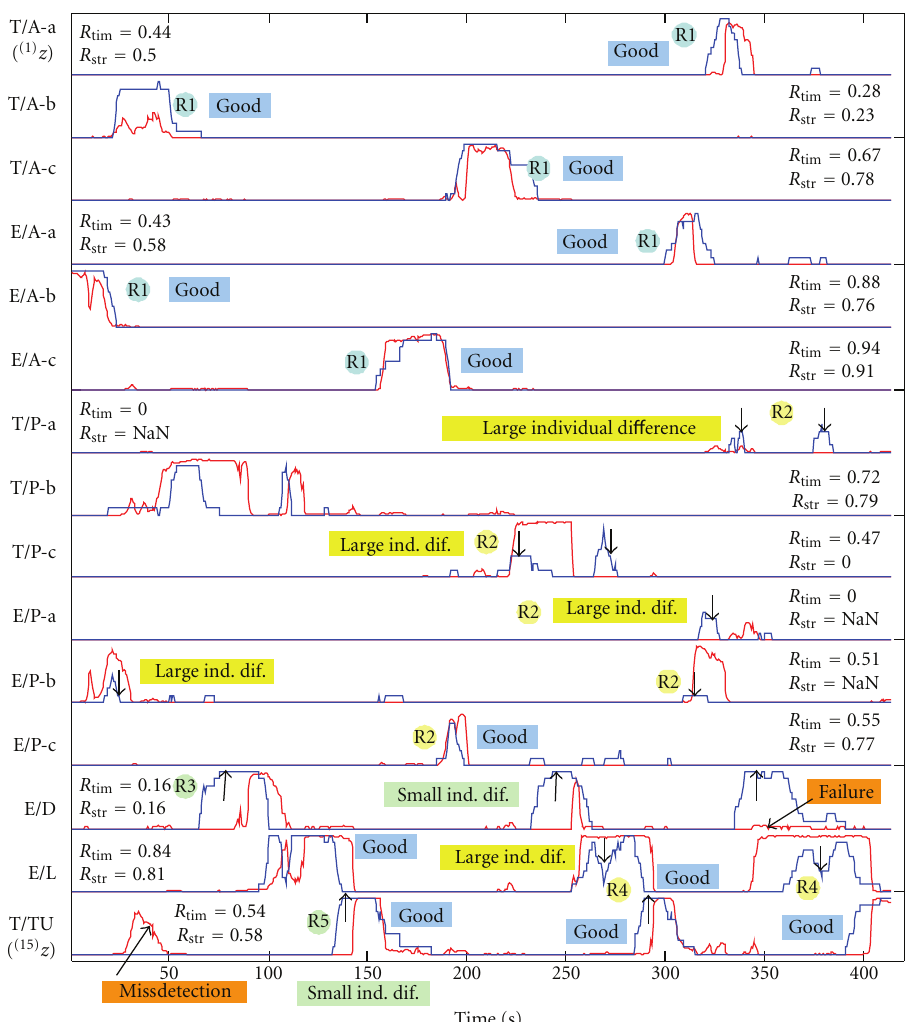
Figure 16: Transitions of intentions: red lines were identified by the SOM-Bayes estimator using scalar ρ . Blue lines were averages of results discerned by eight human